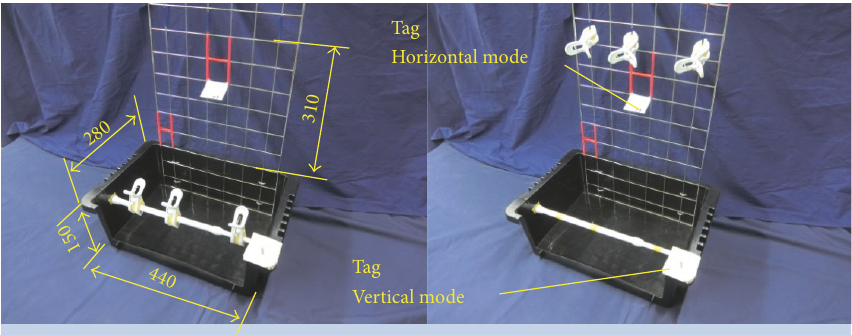
Figure 9: Experimental equipment of Clothespin